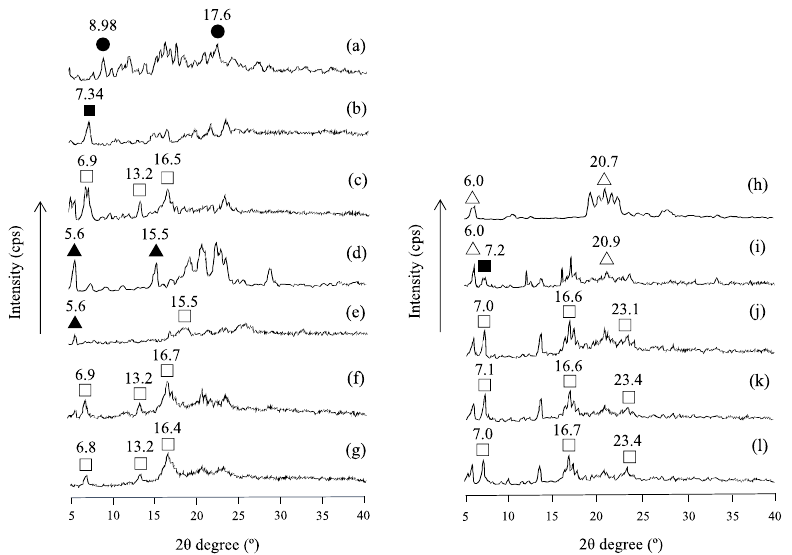
Figure 2. PXRD patterns of: ( a ) γ -CD; ( b ) CD-MOF-1; ( c ) EVP (CD-MOF-1); ( d ) ASCP intact; ( e ) PM (ASCP/CD-MOF-1 = 1/1); ( f ) EVP (ASCP/CD-MOF-1 = 1/1); ( g ) EVP (ASCP/CD-MOF-1 = 1/2); ( h ) ASCDP intact; ( i ) PM (ASDCP/CD-MOF-1 = 1/1); ( j ) EVP (ASCDP/CD-MOF-1 = 1/1); ( k ) EVP (ASCDP/CD-MOF-1 = 1/2); ( l ) EVP (ASCDP/CD-MOF-1 = 1/4). ● : γ -CD original, ■ : CD-MOF-1 original ( α type), □ : CD-MOF-1 original ( β type), ▲ : ASCP original, △ : ASCDP original.